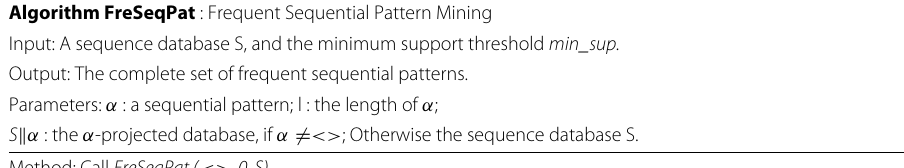
Table 1 Pseudo code of FreSeqPat Algorithm FreSeqPat : Frequent Sequential Pattern